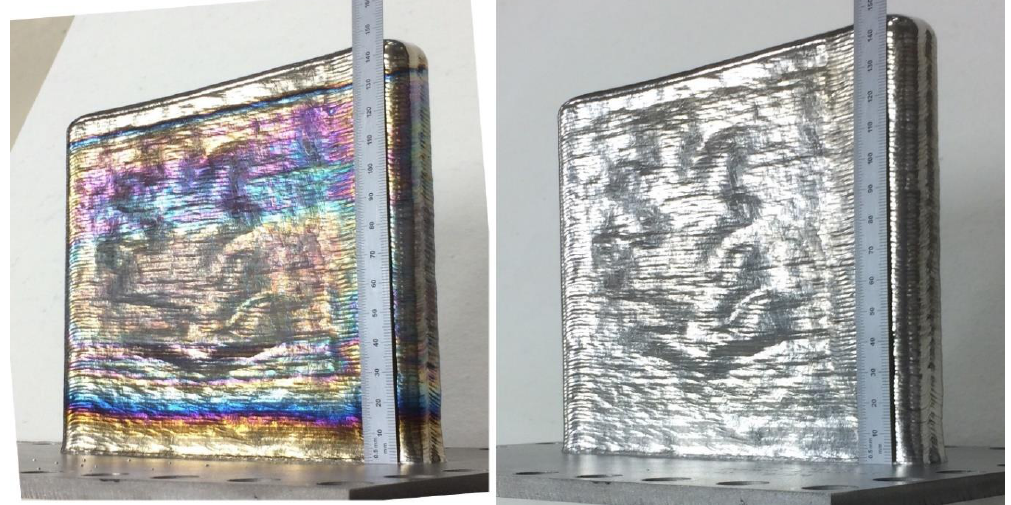
Figure 10. Photographs of Wall 2, side two; as-printed ( left ) and after heat treatment ( right ).